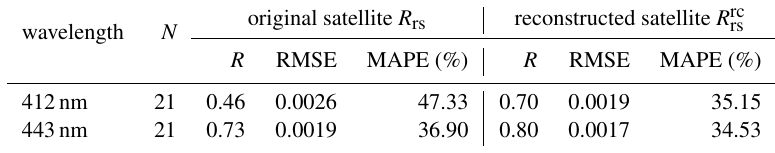
Table 4. Comparison of the original satellite R rs and reconstructed R rc rs with in situ measured data at 412 and 443nm. original satellite R rs wavelength N